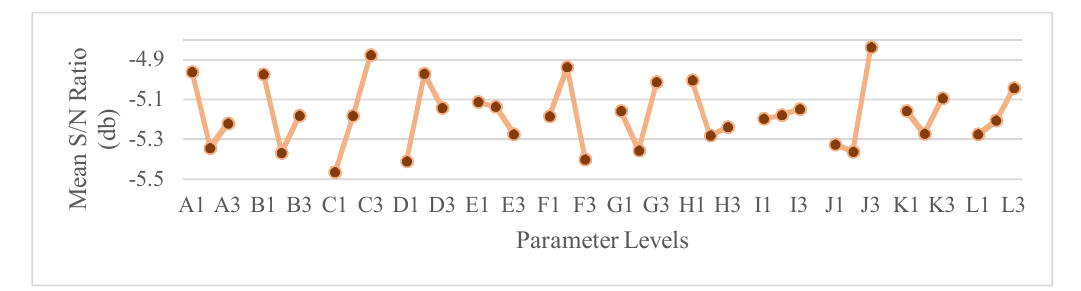
Figure 5. Mean signal-to-noise ratio curves for bead penetration.